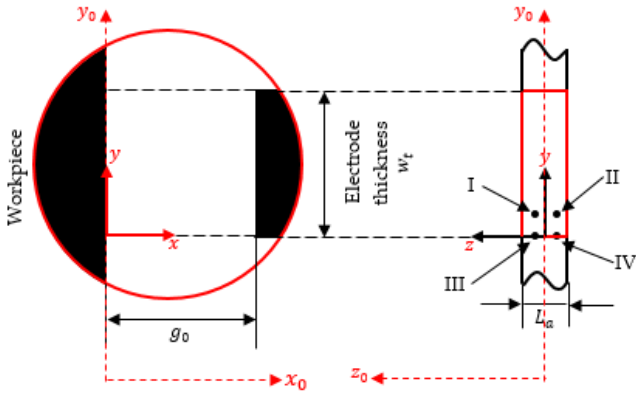
Figure 3 Particle injection locations in fluid domain